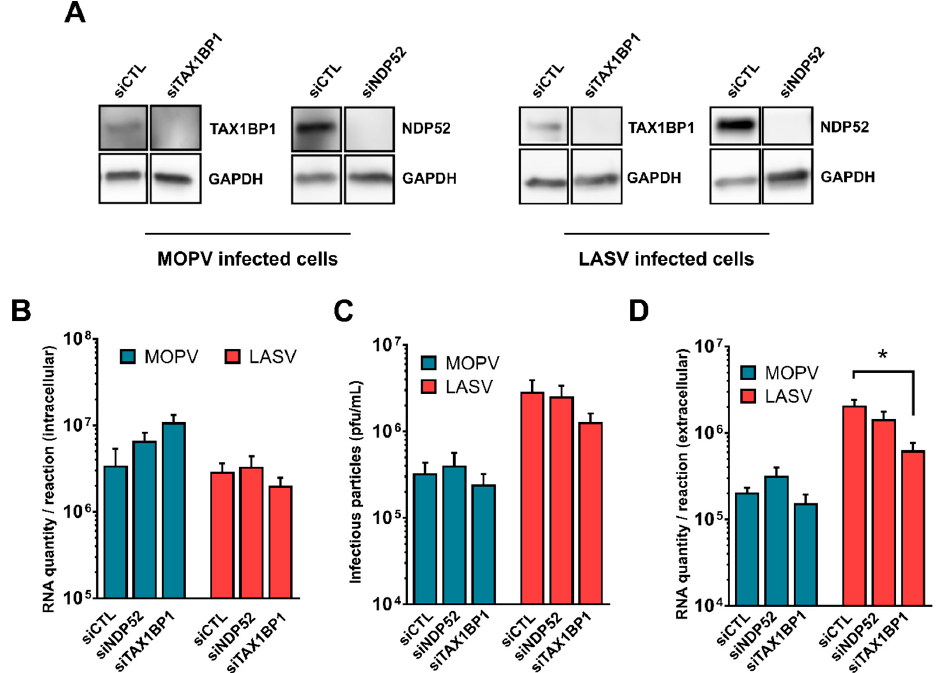
Figure 2. NDP52 and TAX1BP1 are neither involved in the replication nor the release of MOPV or LASV infectious particles. ( A ) HeLa cells were transfected with the indicated siRNA 72 h before analysis of silencing efficiency by Western blotting ( n = 4 independent experiments). ( B – D ) the same cells as in (A) were then infected with LASV or MOPV with an MOI of 0.1 for 1 h before being maintained for three days at 37 °C. Viral RNA was then extracted from the cells and supernatants for quantification by RTqPCR. Infectious particles from the supernatants were also titrated on Vero cells. The error bars represent the standard error of the means from four independent experiments. * indicates p < 0.05, as determined by the Mann–Whitney